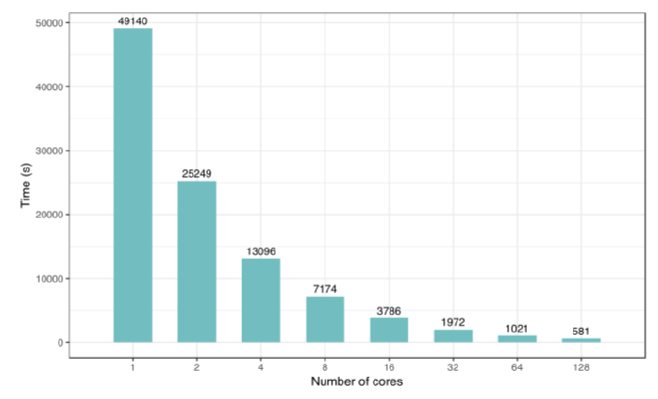
Figure 4: Execution time of the TOTEM dataset analysis with increasing number of partitions